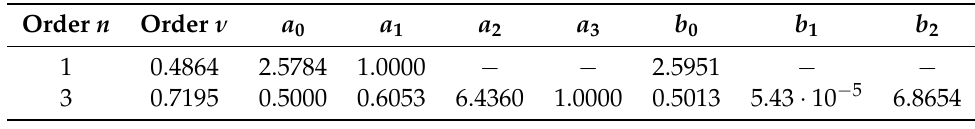
Table 3. Parameters for the fractional-order transfer function G FO ( s ) in Figure 2 and 5 on the basis of the optimized neural network with L = 7 hidden neurons (the fact that b 0 adaptation by the employed optimization routine).